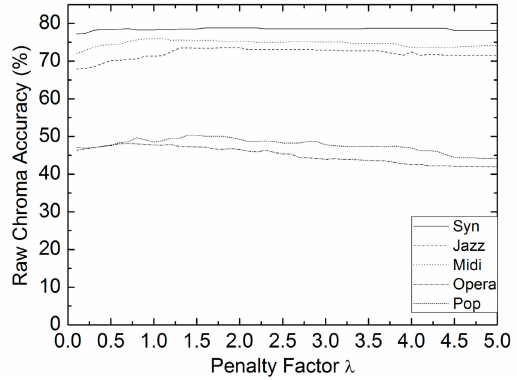
Figure 2. Frame-wise raw chroma accuracy vs. penalty factor for λ different melody